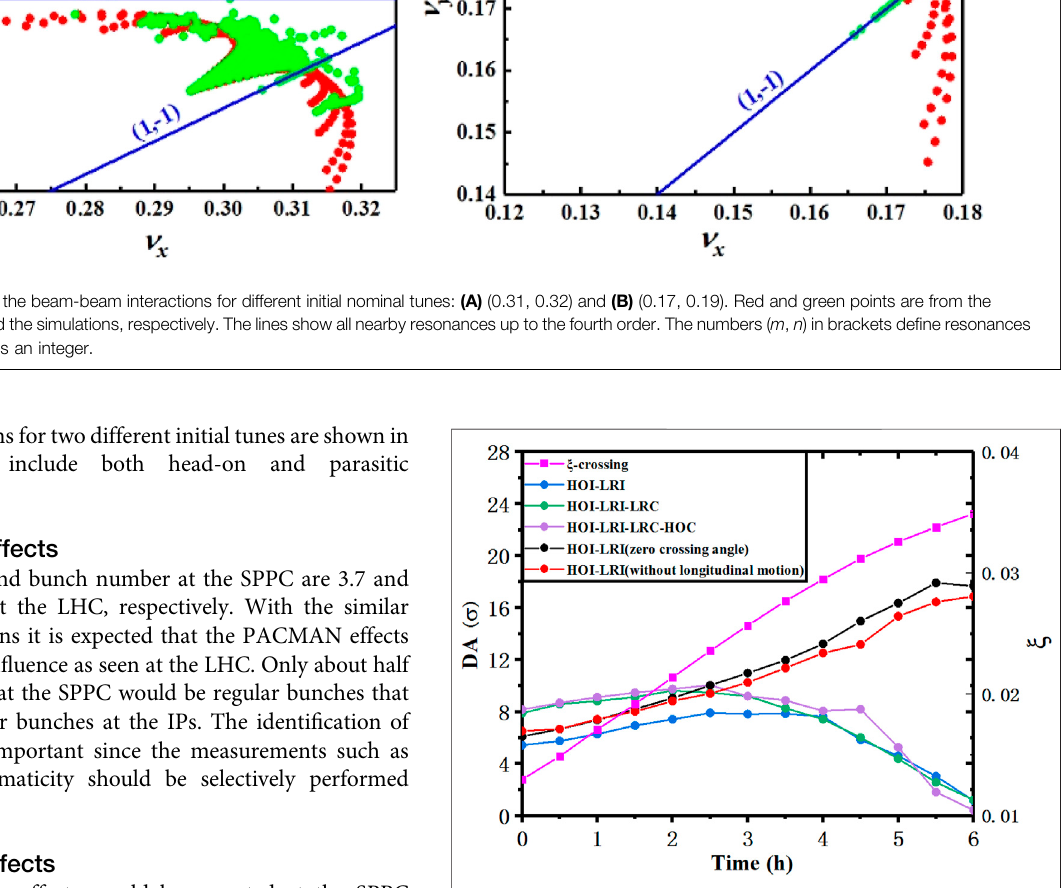
FIGURE 4 | Evolutions of the averaged dynamic aperture (DA, in circles) and beam-beam tune shift parameter (squares) with time including emittance damping and particles burning-off. HOI, LRI, HOC and LRC denote head-on interaction, long-range interaction, head-on compensation and long- range